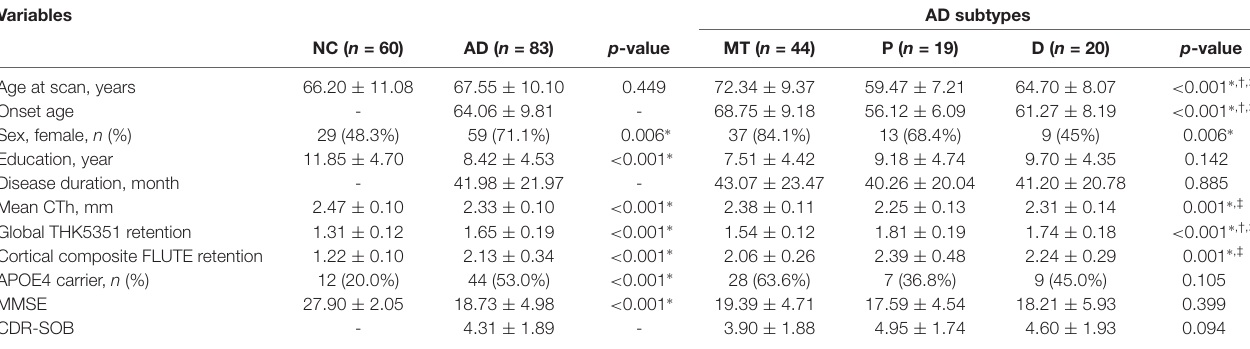
TABLE 1 | Demographic and clinical characteristics of the study population.